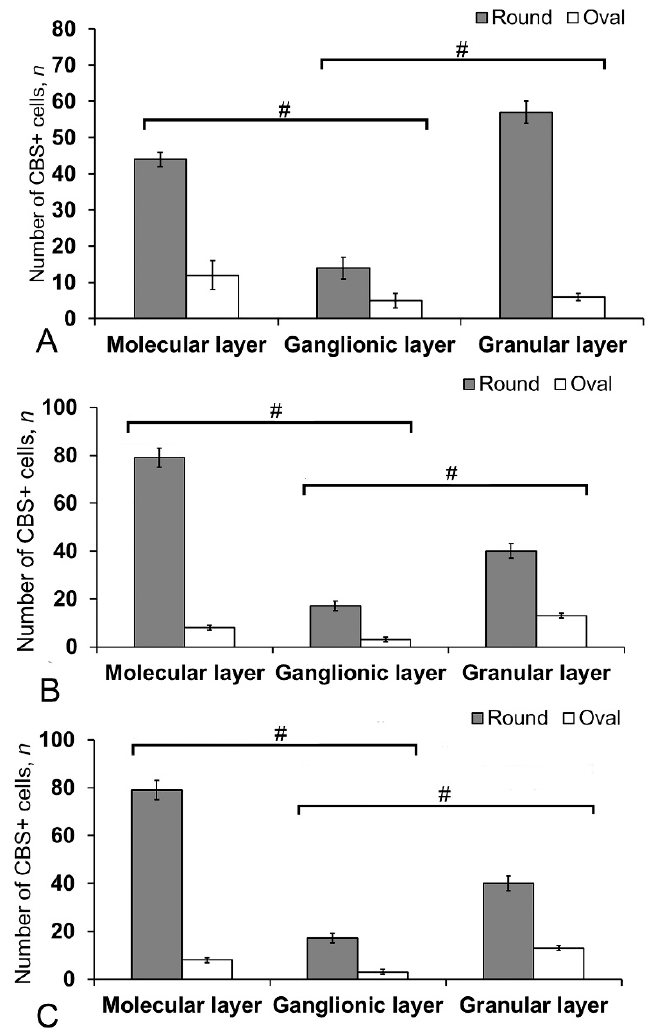
Figure 12. The number of CBS+ cells in the intact cerebellum of juvenile masu salmon, Oncorhynchus masou . ( A ) Dorsal zone. ( B ) Lateral zone. ( C ) Basal zone. Gray columns are CBS+ type 1 cells; white, CBS+ type 2 cells. # significant intergroup differences ( p ≤ 0.05) between molecular/ganglionic layers and ganglionic/granular layers ( A – C ), ( n = 5 in each group; # are significant intergroup differences); one-way analysis of variance (ANOVA). The X-axis indicates the cerebellum layer of juvenile O. masou .